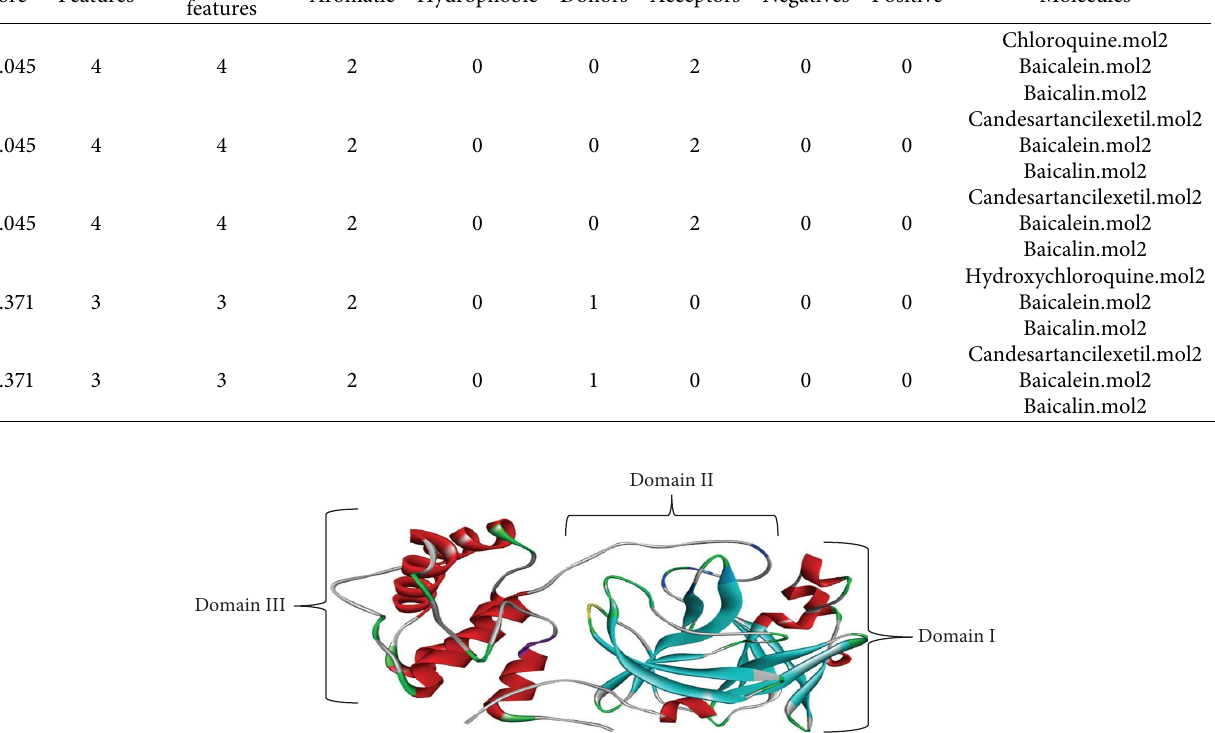
Figure 2: *e pharmacophore with distances between its atoms. *e pharmacophore has three features: one aromatic ring (AR), one hydrogen bond donor (DON), and one hydrogen acceptor (ACC). *e distance between AR and DON is 1.7 ˚A. *e distance between AR and ACC is 4.2 ˚A. *e distance between ACC and DON is 3.4 ˚A. Table 4: Drug-likeness test results of the 34 molecule s